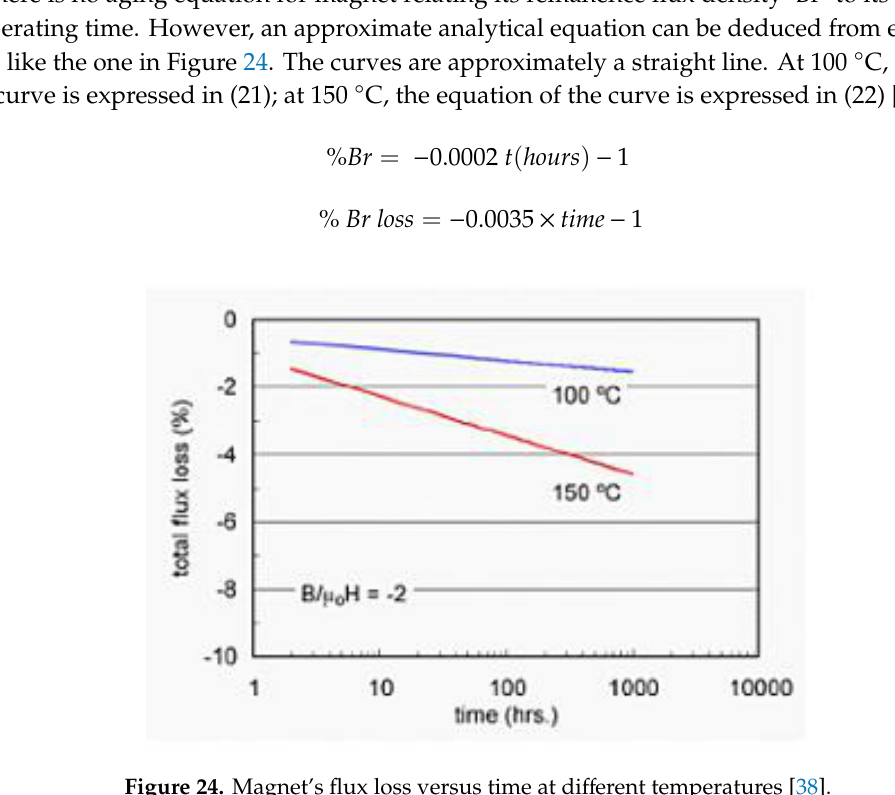
Figure 24. Magnet’s flux loss versus time at di ff erent temperatures [38]. Figure 24. Magnet ’ s flux loss versus time at different temperatures [38]. Table 6. Effect of magnet aging on its Br and Hc (100 °C). Table 6. E ff ect of magnet aging on its Br and Hc (100 ◦ C).